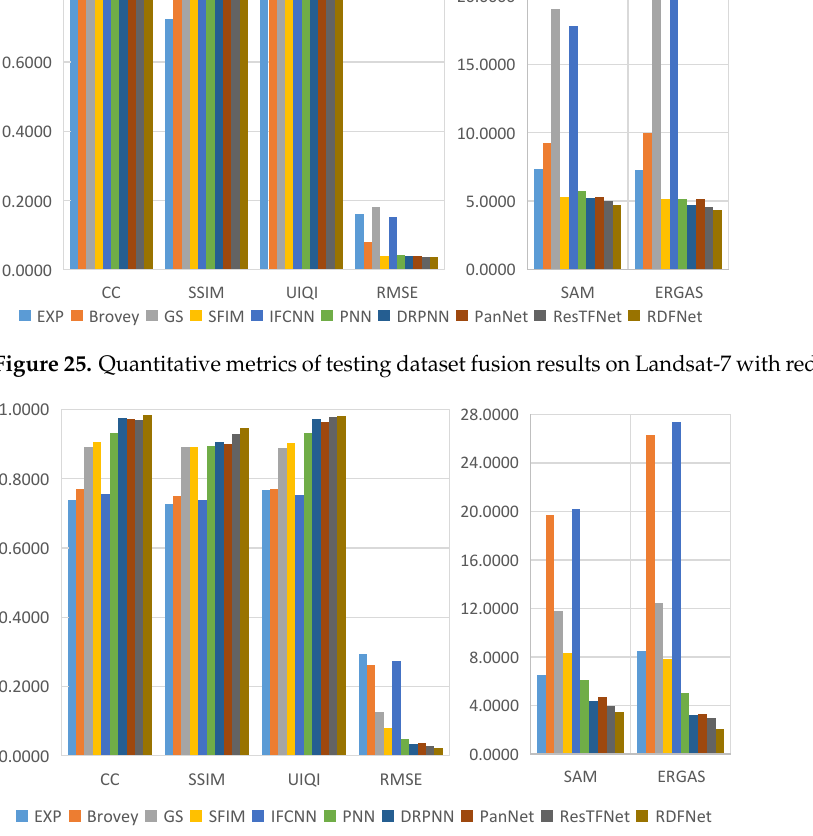
Figure 26. Quantitative metrics of testing dataset fusion results on GF-2 with reduced resolution. In order to comprehensively analyze the fusion performance of the network, Figure 27 shows the fusion time of the testing datasets on low resolution. In the future, we will employ the combination of extracting high-frequency information and deep network to explore the lighter fusion model.